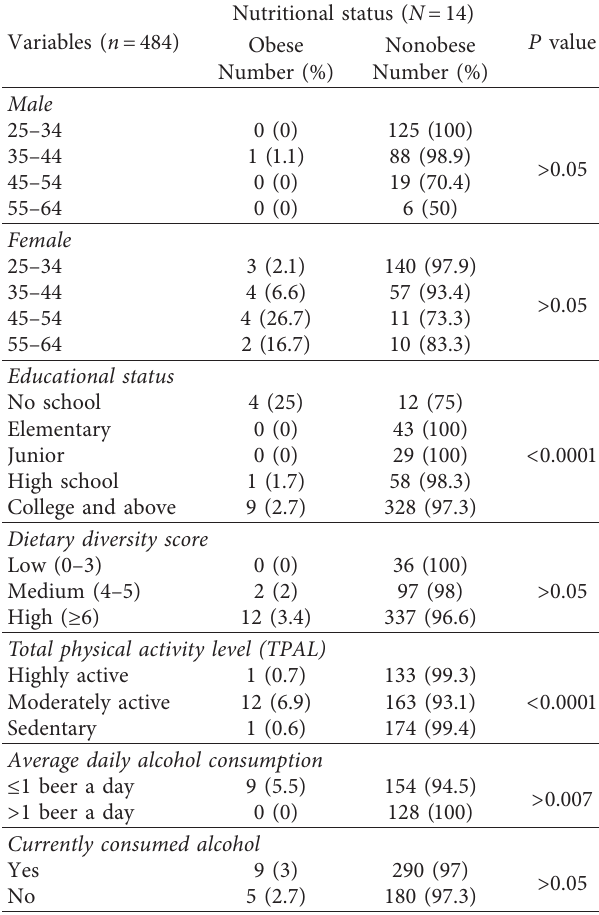
Table 3: Prevalence of obesity by sex with age group, educational status, dietary diversity score, alcohol consumption, and total physical activity level among adults in Addis Ababa,